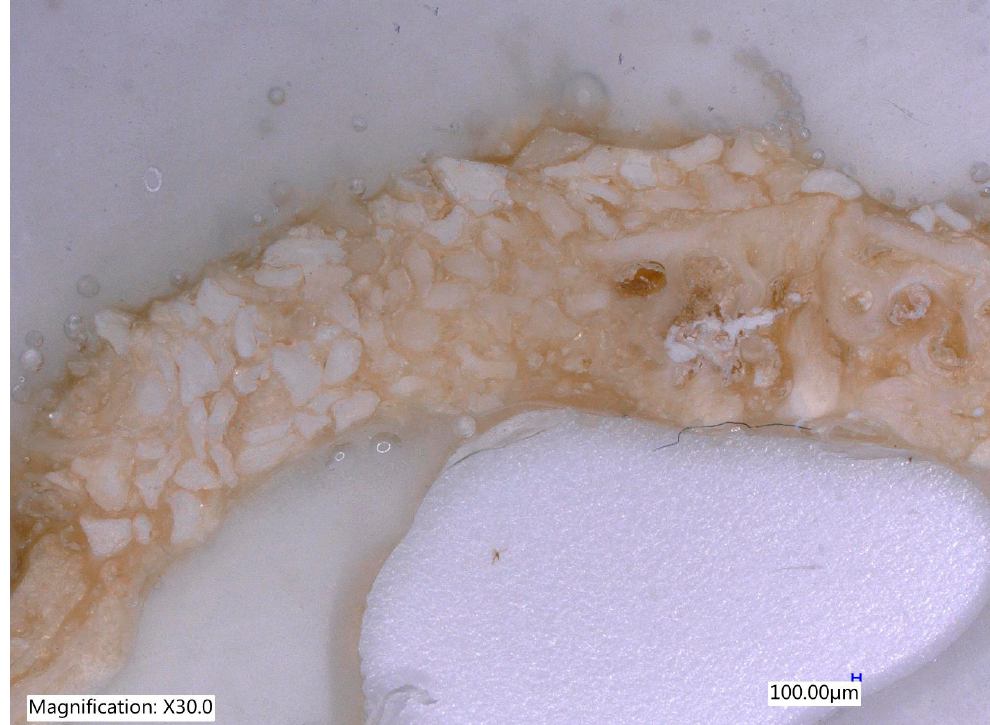
Figure 14. Teeth particles after 8 weeks of evaluation. The original volume of the defects in all specimens was preserved by means of bone graft materials (magnification 30×).